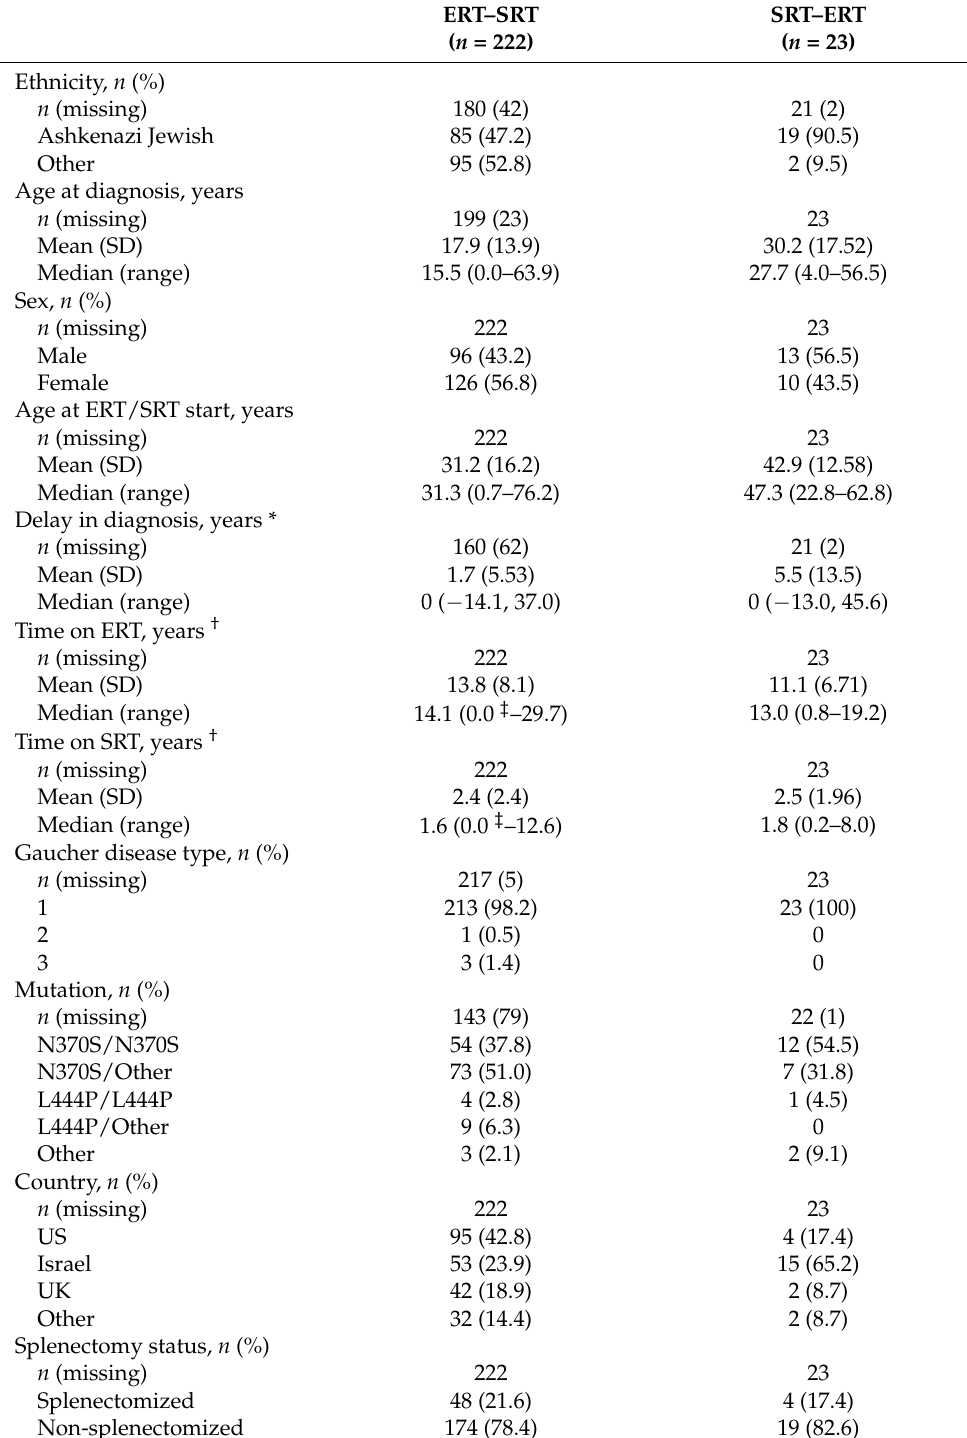
Table 1. Patient demographics at